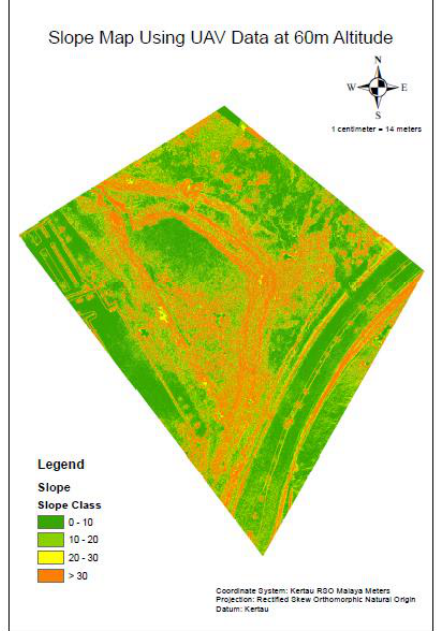
Figure 19. Slope Map Generated Using LiDAR Data at 60m